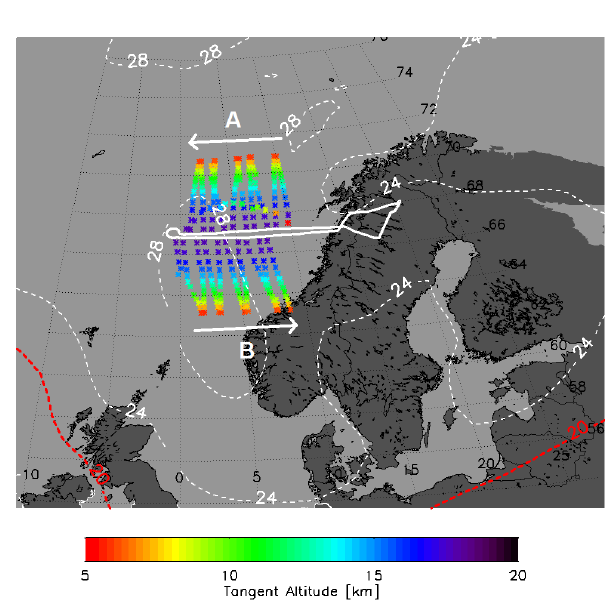
Figure 8. MIPAS-STR observations and meteorological situation during the flight on 30 January 2010 under conditions free of